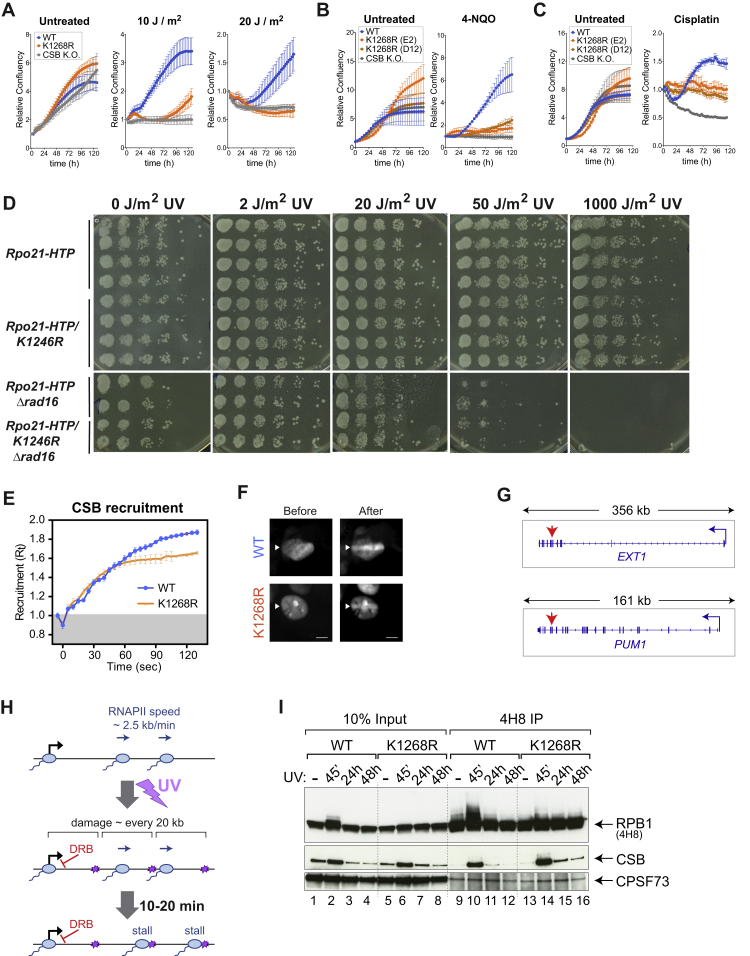
K1268 Ubiquitylation Is Required for Cell Survival upon DNA Damage but Not for TC-NER, Related to Figure 2(A) Growth assays before and after UV irradiation (10 J/m2 and 20 J/m2), in WT and K1268R switchover model systems and CSB knock-out cells. Cell growth (confluency) was monitored every 3 h using Incucyte and the data were normalized to t = 0 for each well. Data are represented at each 3h time point as average relative confluency of 3 biological replicates ± SD. Please note that normalization to t = 0 results in technical variability between samples, such as the impression that K1268R cells grow better than WT cells in untreated condition, however this is not significant or reproducible.(B and C) Growth assays before and after the treatment with 4-NQO (0.5 μM for 1 h) (B) or cisplatin (90 μM for 1 h) (C), in WT and K1268R CRISPR knock-in and CSB knock-out cells. Cell growth (confluency) was monitored every 4 h (B) or every 3 h (C) using Incucyte and the data were normalized to t = 0 for each well. Data are represented at each 3h/4h time point as average relative confluency of 3 biological replicates ± SD(D) Sensitivity of yeast cells with the genotype shown on the left, to the levels of UV irradiation shown above.(E) Recruitment of GFP-tagged CSB in either parental HEK293T cells (WT, Blue) or in cells carrying the K1268R RPB1 mutation (K1268R, Orange). Micro-irradiation was initiated at time t = 0, and cells were imaged every second, with intensity values binned over 5 s intervals. Graphs show mean ± SEM, n = 18 cells (6 cells from each of 3 independent experiments).(F) Representative images of either WT or K1268R cells before and after being subjected to micro-irradiation; white triangles indicate regions of micro-irradiation, scale bars, 8 μm.(G) Gene browser snapshots showing the location of primers (red arrows) used for measuring transcription restart on two long genes, EXT1 and PUM1.(H) A sketch depicting the time frame within which all RNAPII will stall at DNA damages, upon UV irradiation of 20 J/m2. Addition of DRB in the DRB run-off experiment, blocking the new release of RNAPII into elongation, is indicated in red.(I) Immunoprecipitation (IP) of RPB1 from chromatin fractions followed by western blot for RPB1, CSB and CPSF73. WT and K1268R CRISPR knock-in (clone E2) cells were either untreated or UV-irradiated with 20 J/m2 and collected 45 min, 24 h and 48 h later. IP was carried out with 4H8 RPB1 antibody.